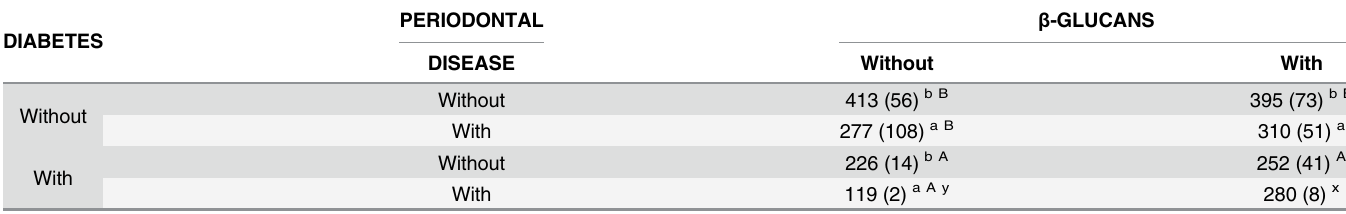
Table 2. Serum levels of C-peptide (pM — mean ± standard deviation) of animals treated with β -glucans from Saccharomyces cerevisiae (30mg/kg/ day) during 28 days. PERIODONTAL DIABETES DISEASE Without With Without Without With Without With With 280 (8) x A,B Means followed by different letters in columns indicate signi fi cant differences between groups with and without diabetes by F test (p < 0,05). a,b Means followed by different letters in columns indicate signi fi cant differences between groups with and without periodontal disease by F test (p < 0,05). x,y Means followed by different letters in lines indicate signi fi cant differences between groups with and without β -glucan ingestion by F test (p <